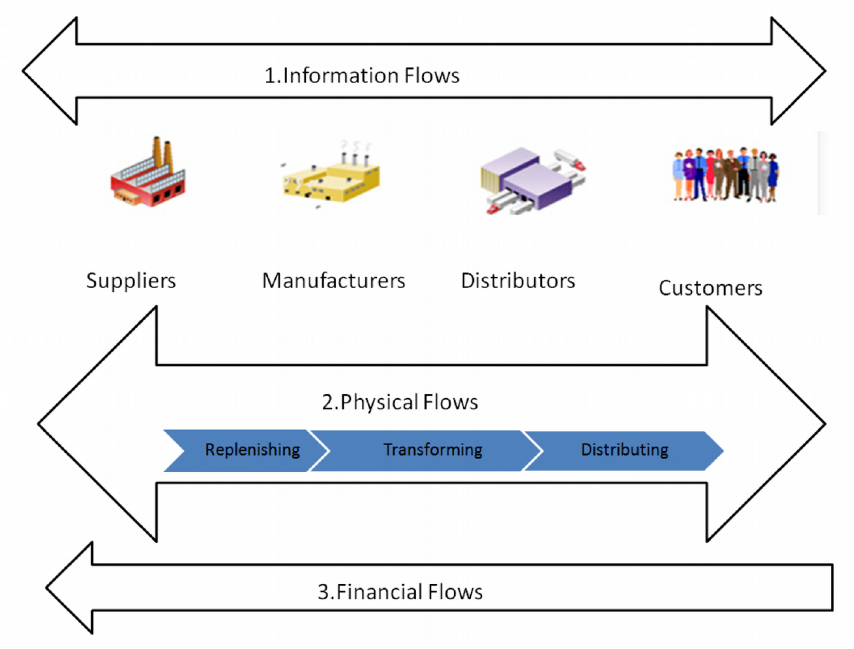
Figure 1. Supply Chain Flows Presentation (Bekkali,